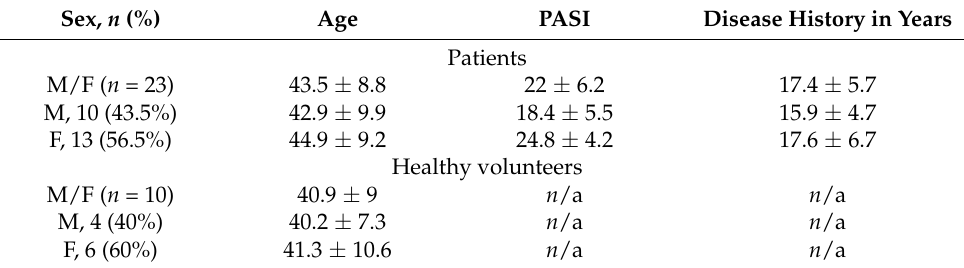
Table 1. Clinical parameters of patients with psoriasis ( Psoriasis vulgaris